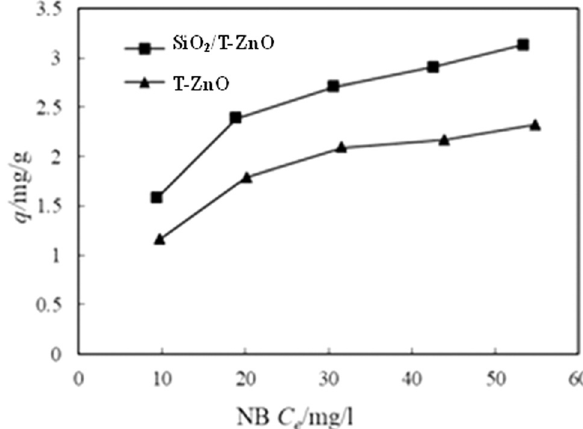
Figure 4: UV - Visible di ff use re fl ectance spectra of SiO 2 ( AG ) , T - ZnO, and SiO 2 ( AG ) /T - ZnO. Figure 5: Adsorption isotherms of NB by T - ZnO and SiO